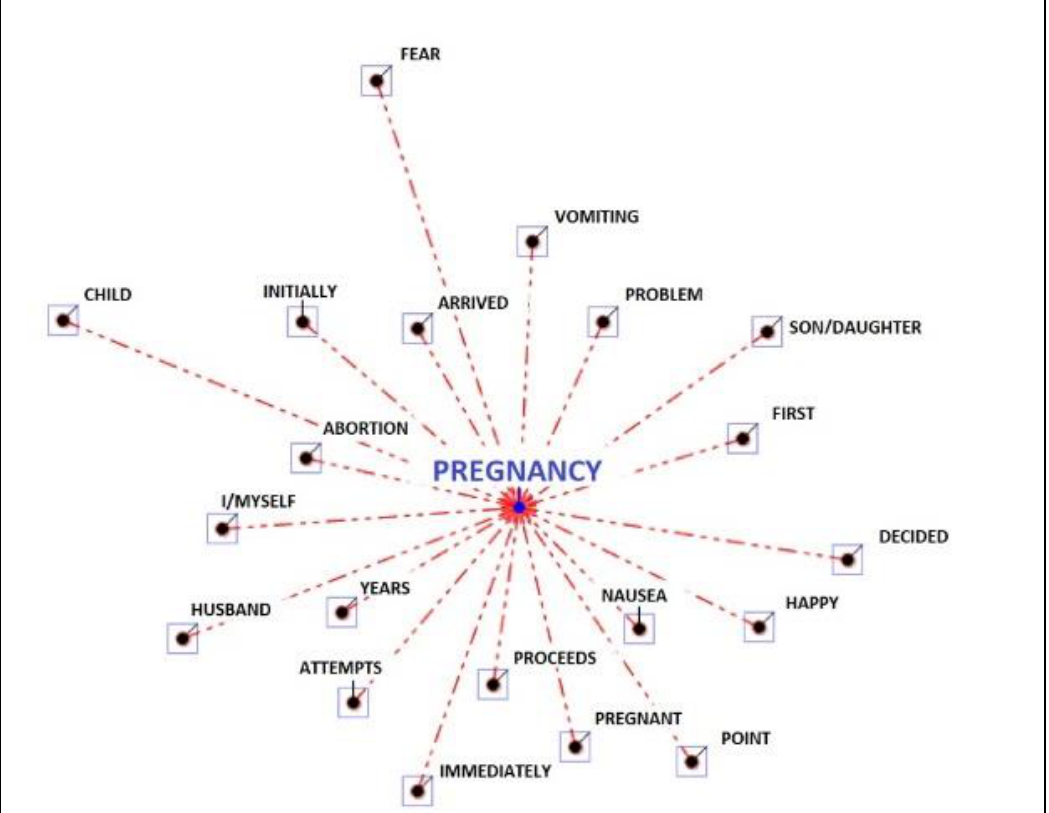
Figure 1. Associations to the word “pregnancy”, referring to the topic “perception pregnancy”.